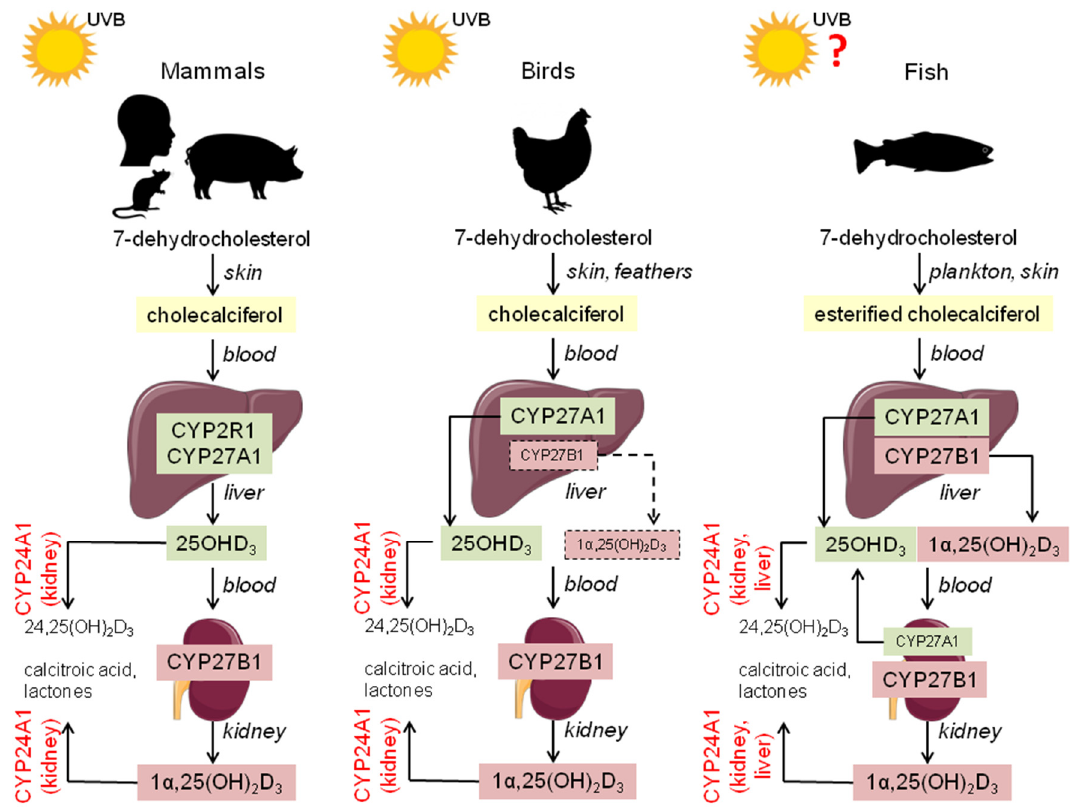
Figure 1. General pathways of vitamin D 3 metabolism in mammals, birds, and fish. Abbreviations: CYP2R1 and CYP27A1= 25-hydroxylases; CYP27B1 = 1 α -hydroxylase; CYP24A1 = 24-hydroxylase; UVB = ultraviolet B irradiation; ? = knowledge about synthesis is inconsistent.